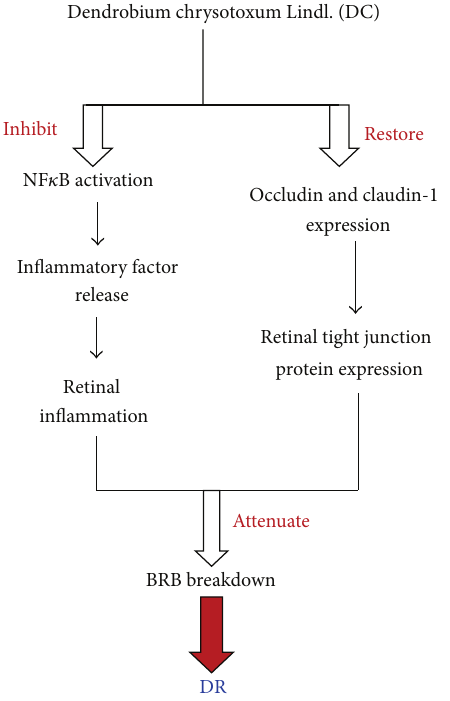
Figure 6: The schematic diagram of mechanism involved in the amelioration of DC against DR in STZ-induced diabetic